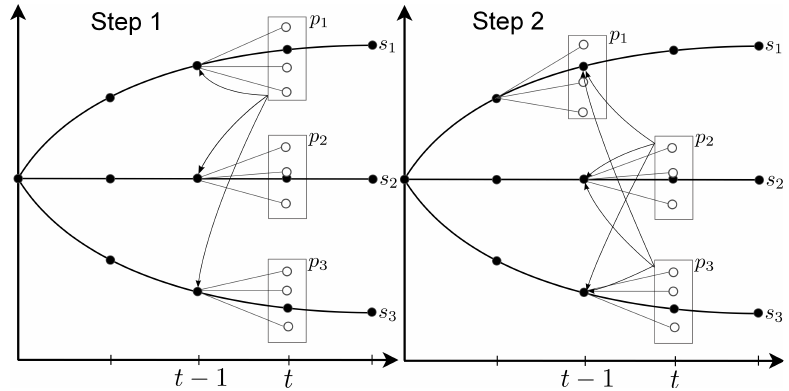
Figure 2. Parallel processing scheme used in the backward iteration. Each of the processors p 1 − p 3 solves N B linear programming (LP) problems and sends one cut to all states at stage t − 1, as indicated by black